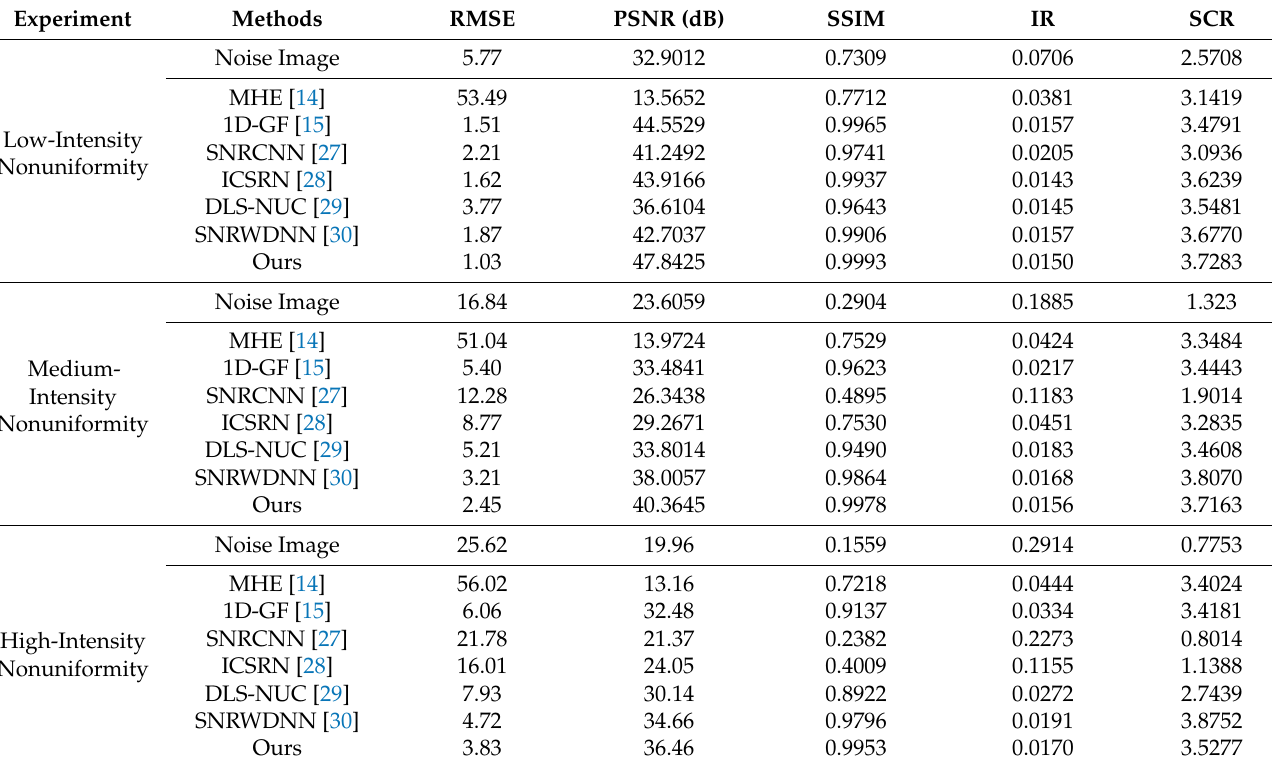
Table 1. Evaluation metric results of the methods on simulated data with different intensities of nonuniform noise.